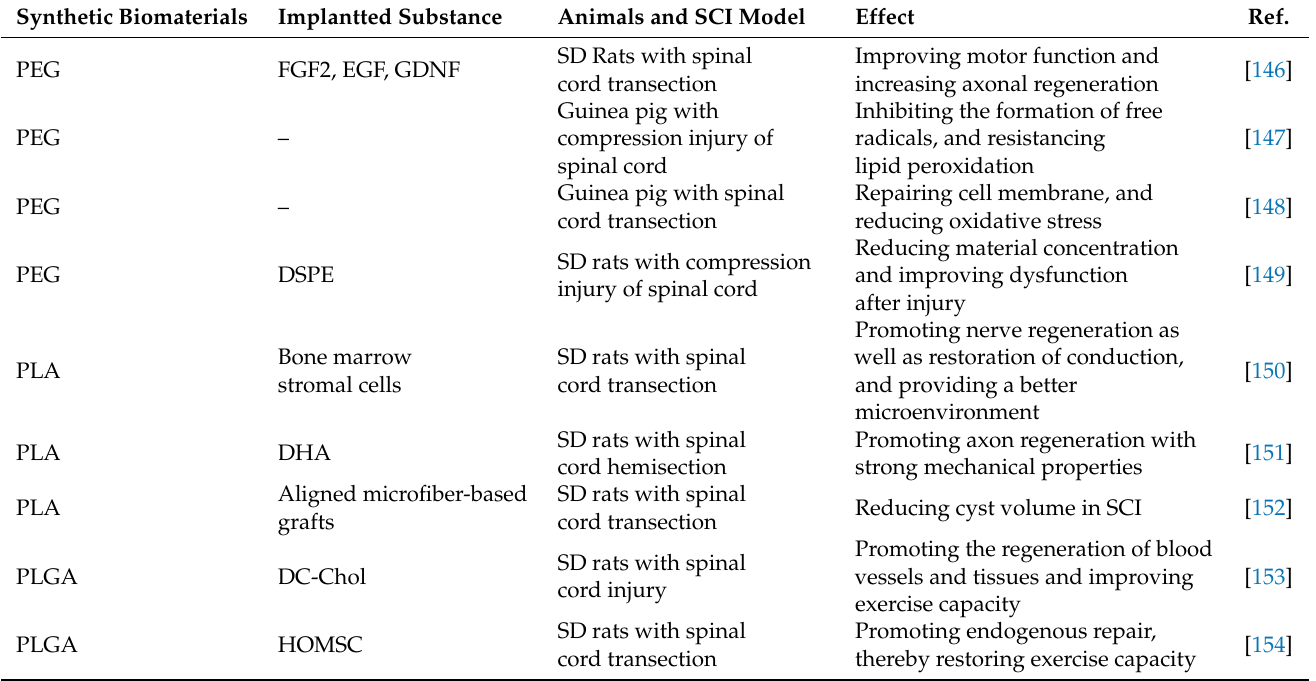
Table 2. The bioactivity of synthetic biomaterials in various models of SCI. Synthetic Biomaterials Implantted Substance Animals and SCI Model Effect Ref. Improving motor function and increasing axonal